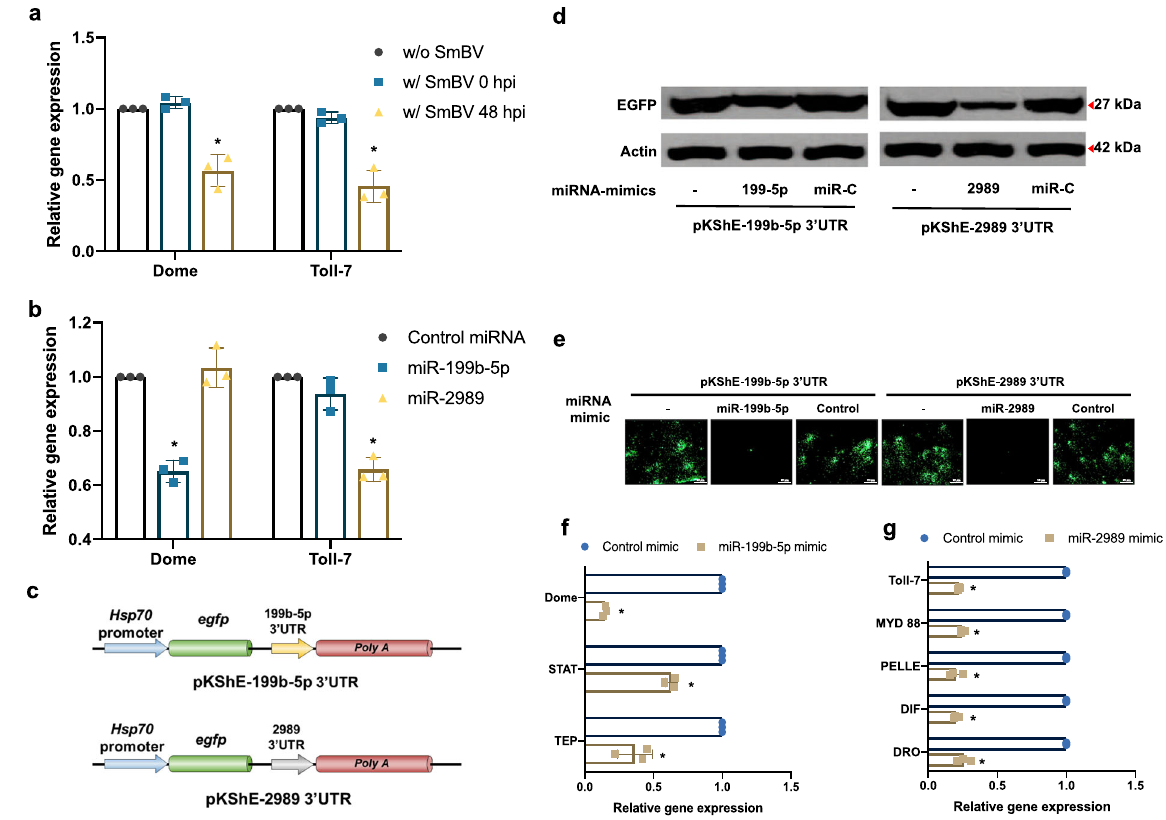
Fig. 2 miR-199b-5p and miR-2989 inhibit the humoral immunity pathway. a Expression levels of humoral immunity genes, domeless (Dome) and toll-7 (Toll-7), were quanti fi ed by qPCR in SL1A cells 48 h after infection with SmBV. b Expression levels of domeless (Dome) and toll-7 (Toll-7) were quanti fi ed by qPCR in SL1A cells 48 h after transfection with mimic of miR-199b-5p and miR-2989, and a control miRNA, respectively. c Reporter plasmids pKShE- 199b-5p 3 ′ UTR and pKShE-2989 3 ′ UTR in which the 3 ′ -UTR of Domeless or Toll-7 were fused to the 3 ′ -end of an EGFP coding region, respectively. These two reporter plasmids were transfected into SL1A cells with corresponding miRNA mimic or a control miRNA (Control). EGFP expression was detected at 48 h after transfection and quanti fi ed by d western blotting analysis and e fl uorescent microscopy. Genes in JAK/STAT ( f ) and Toll ( g ) pathways decreased in expression after the transfection of miR-199b-5p- or miR-2989 mimic. The expression levels of genes in the signal cascade of the JAK/STAT pathway [ domeless (DOME), STAT (STAT), and TEP (TEP)] and the Toll pathway [ toll (TOLL), myd88 (MYD88), pelle (PELLE), dif (DIF), and drosomycin (DRO)] were determined by qPCR in SL1A cells transfected with miRNA mimics of miR-199b-5p and miR-2989, respectively. An actin signal was used as an internal control to normalize all readings. All experiments were performed with three biological replicates ( n = 3). Data are expressed as the mean and standard deviation (SD). p -value were calculated using Student ’ s t -test (* p <